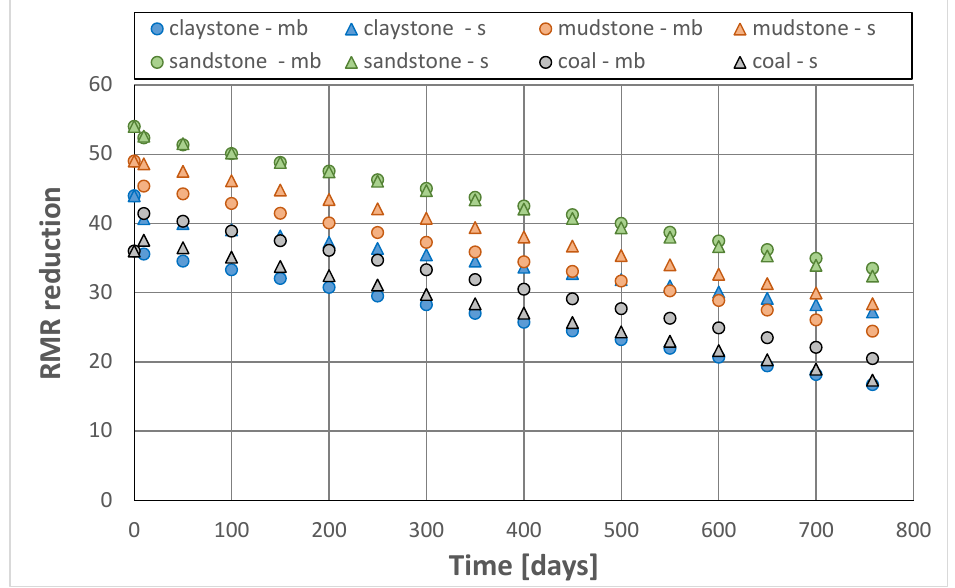
Figure 12. Changes in Hoek – Brown parameter s for rocks around roadway D-2, chainage 595 m. As expected, the trendlines of the changes in the m b and s parameters versus time since excavation are exponential functions, for which the coefficient of determination reaches high values within the 0.95–0.99 range. The trendlines and their corresponding equations are shown in Figures 11 and 12.